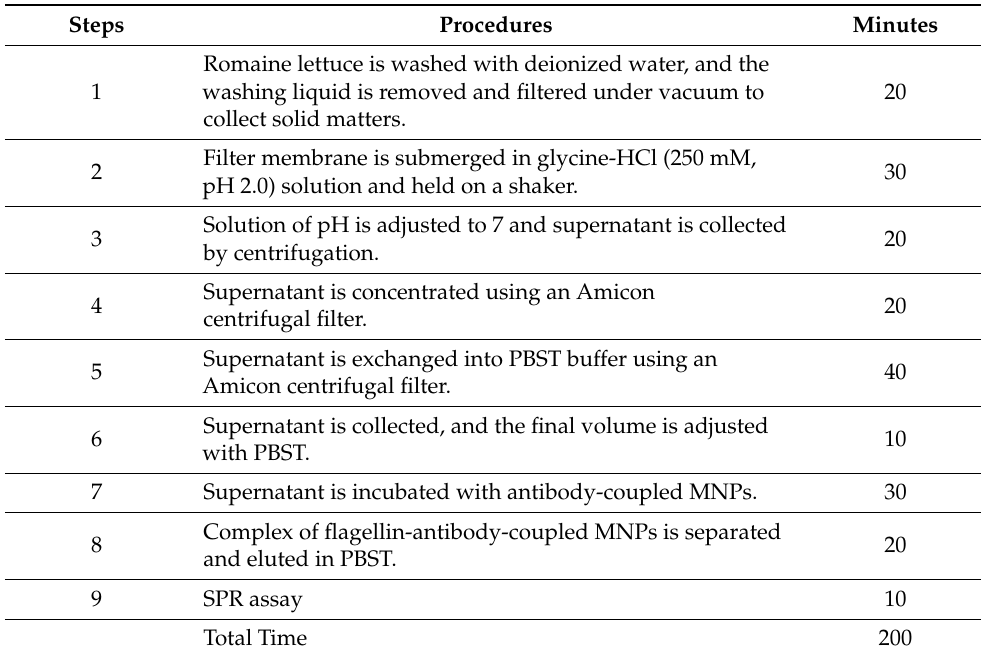
Table 1. A summary of the preparation of flagellin sample from romaine lettuce for the SPR